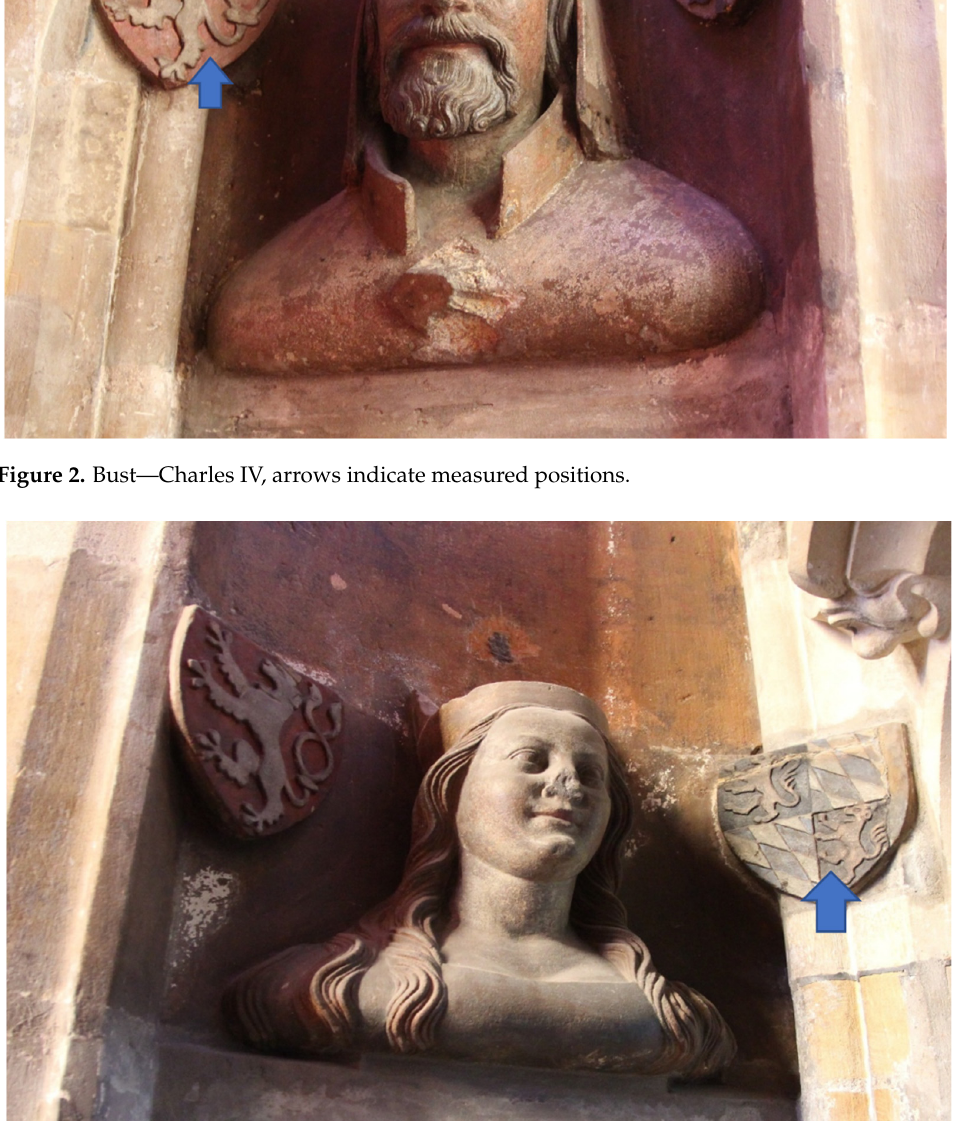
Figure 4. Spectrum of red lead.